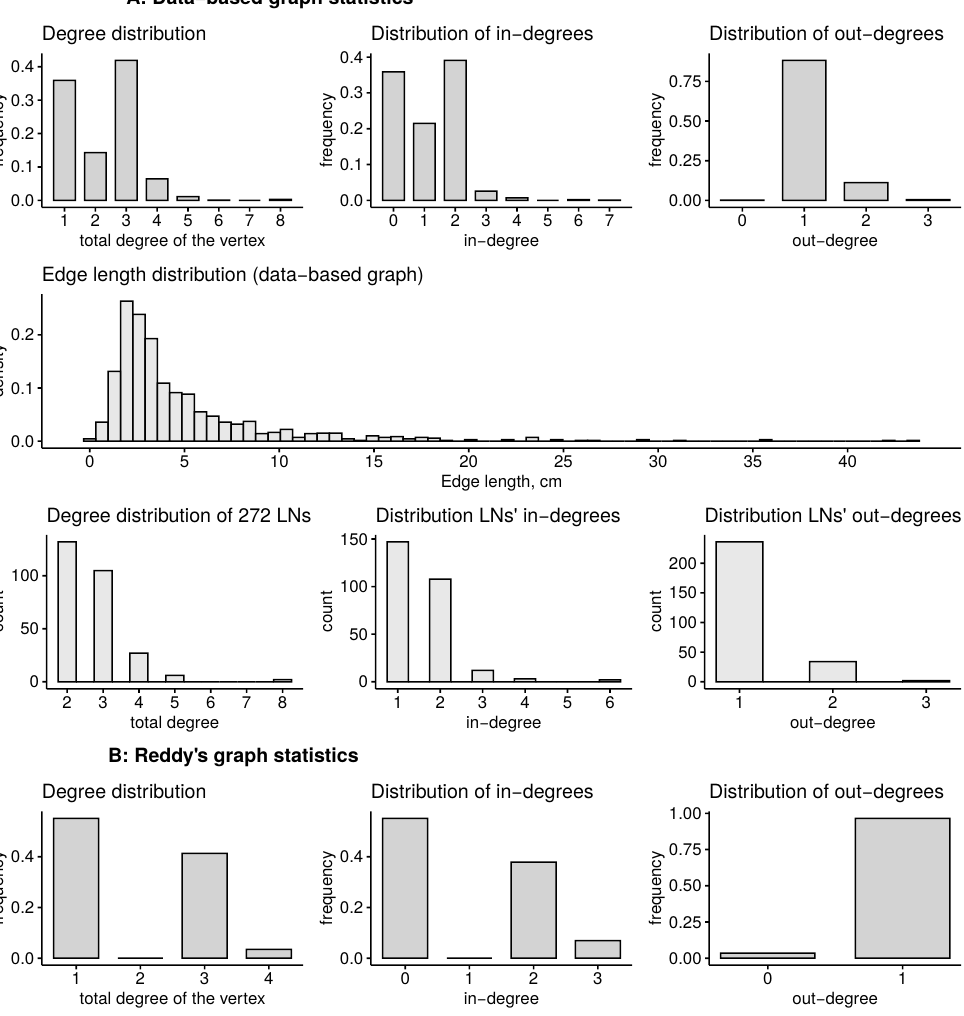
Figure 3. Statistical distributions of the anatomy data-based HLS graphs. ( A ) Statistics of the data-based graph, ( B ) of the Reddy’s graph. Statistics include the distributions of total degrees of the vertices, distributions of in- and out-degrees, as well as the edge-length distribution and degree distribution of the vertices that represent the lymph nodes (LNs) for data-based